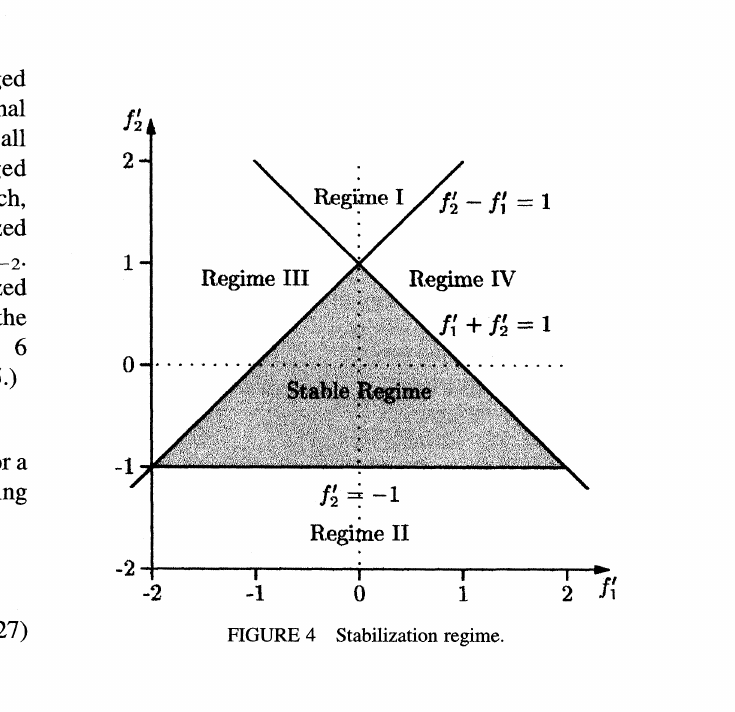
FIGURE4 Stabilization